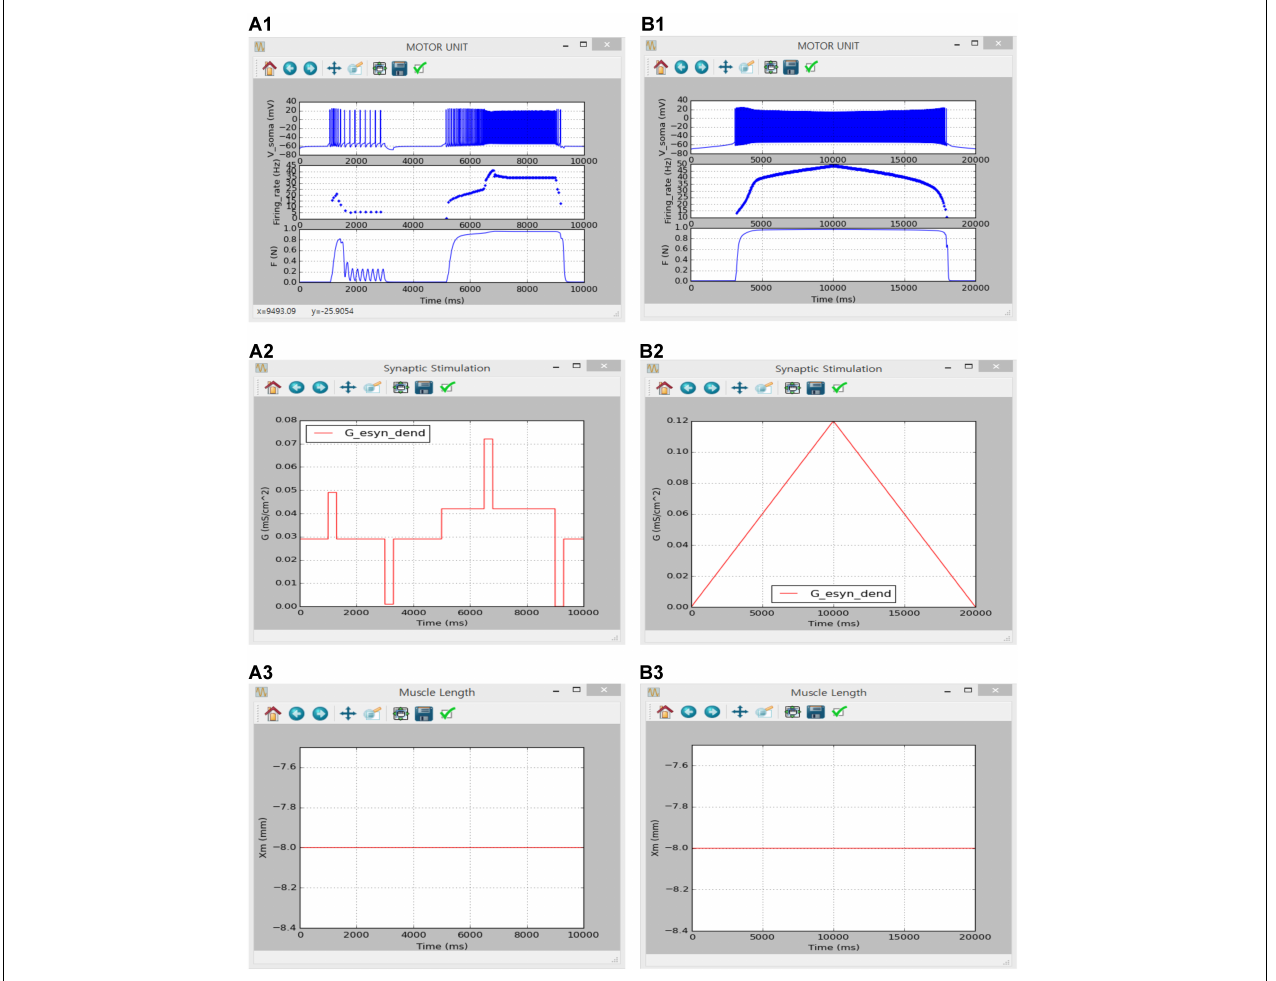
FIGURE 9 | Non-linear input-output behavior of a slow motor unit with G esyn , dend . (A1–A3) Voltage responses at the soma (V soma , upper panel in A1 ), instantaneous firing rate (Firing_rate, middle panel in A1 ) and muscle force (F, bottom panel in A1 ) in response to the step variation with alternating excitatory and inhibitory pulses in excitatory synaptic conductance at the dendrite (G esy , dend , A2 ) at the optimal muscle length (X m , A3 ). (B1–B3) Voltage responses at the soma (V soma , upper panel in B1 ), instantaneous firing rate (Firing_rate, middle panel in B1 ) and muscle force (F, bottom panel in B1 ) against slowly ascending and descending variation in excitatory synaptic conductance at the dendrite (G esy , dend , B2 ) while maintaining the optimal muscle length (X m , B3